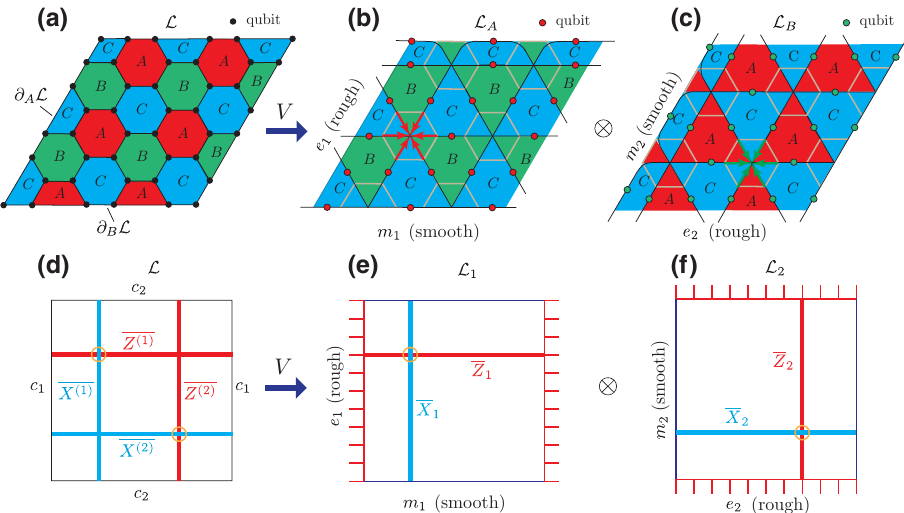
FIG. 40. (a)–(c) Disentangling a 2D color code defined on a hexagonal lattice (qubits located on the vertices) into a tensor product of two surface codes defined on triangular lattices (qubits located on the edges) by shrinking the color- A faces and color- B faces, respectively, into a single vertex. The color-code boundary with color A ( B ) is turned into a rough (smooth) boundary condensing e -anyons ( m -anyons) in the first (second) copy of the surface code. (d)–(f) The effective TQFT picture of the lattice model in (a)–(c), i.e., disentangling a square-patch color code into two square-patch surface codes. Two pairs of logical operators in the color code are mapped into the corresponding pair of logical operators within each surface code.